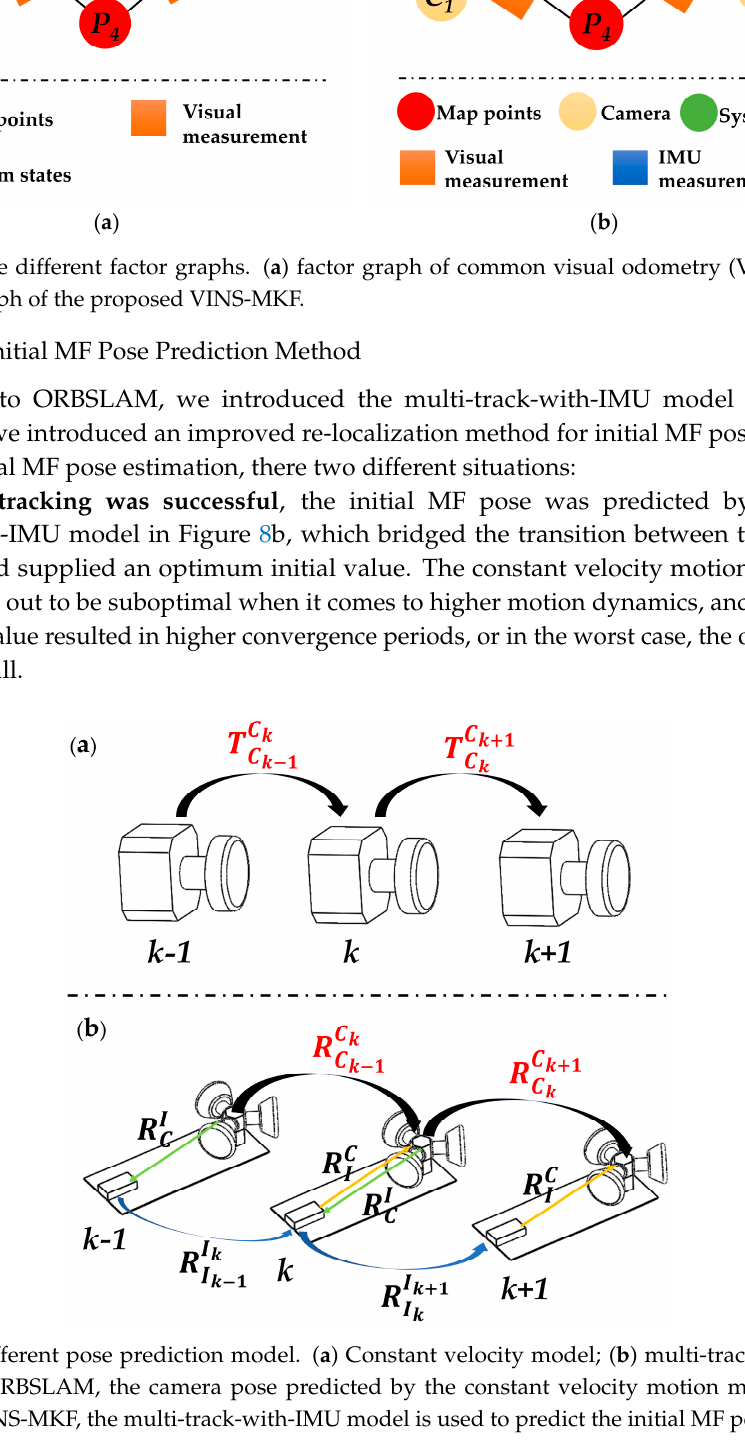
Figure 8. Different pose prediction model. ( a ) Constant velocity model; ( b ) multi-track-with-IMU model. In ORBSLAM, the camera pose predicted by the constant velocity motion model, in the proposed VINS-MKF, the multi-track-with-IMU model is used to predict the initial MF pose.